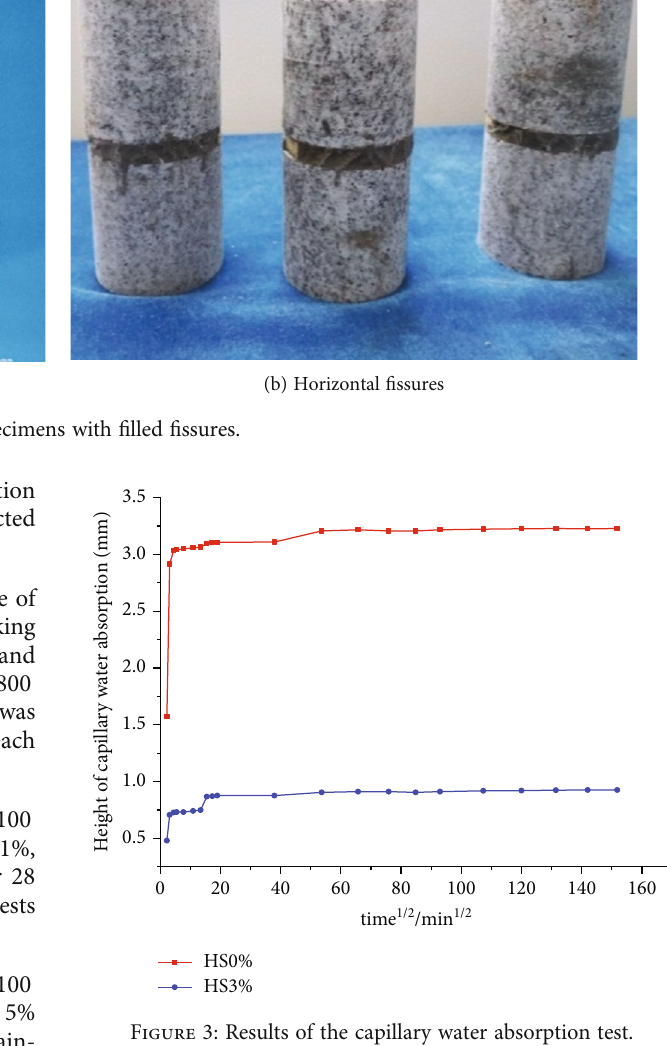
Figure 3: Results of the capillary water absorption